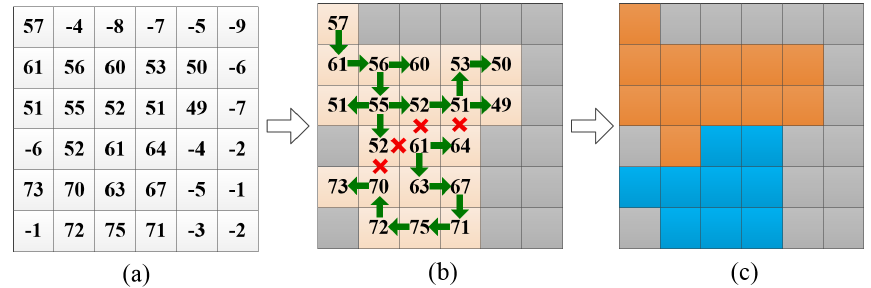
Figure 4. Erroneous area detection with a path propagation algorithm. (a) TDM DEM − REMA elevation difference values in meters. (b) Elevation jump detection with path propagation. Green arrows and red crosses represent the adjacent pixels which can and cannot, respectively, be merged along the propagation path. Grey: background pixels. (c) Resulting automatically merged regions in orange and blue with mean elevation difference of 53.9 and 68.4m,